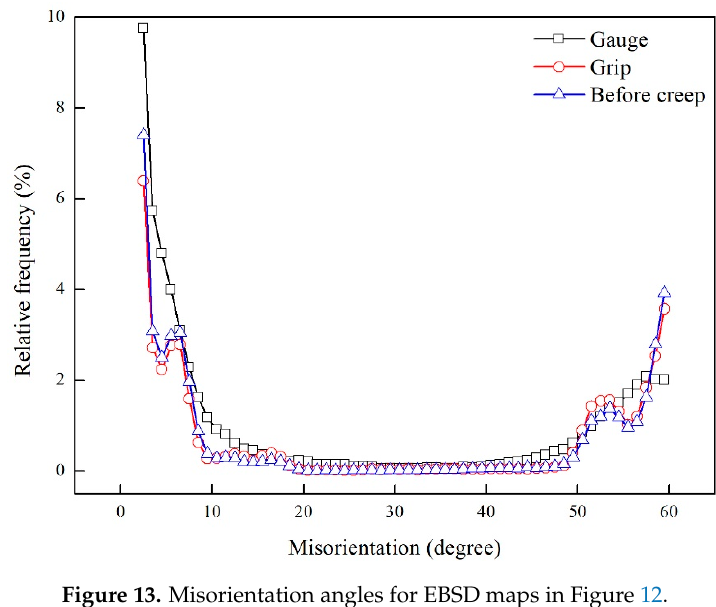
Figure 13. Misorientation angles for EBSD maps in Figure 12.